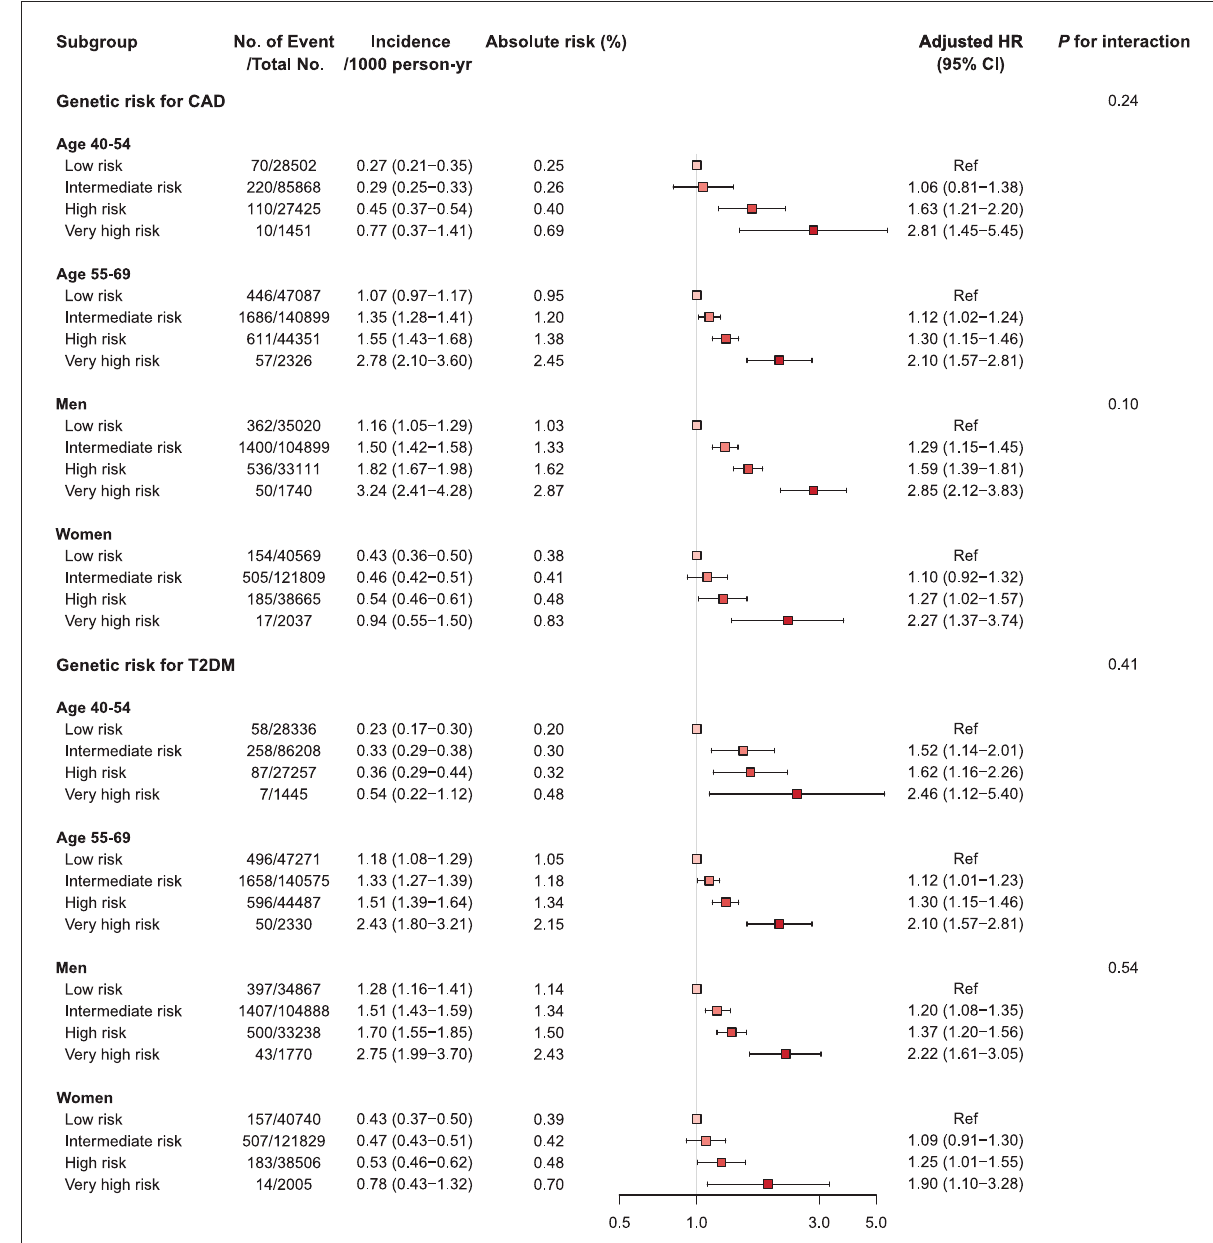
FIGURE3 Forest plot of cardiovascular mortality according to genetic risk, age, and sex. Cox regression model was adjusted for age, sex, genotyping array, and first ten principal components of ancestry. p -values are for testing the interaction between each genetic risk category, age, and sex. CAD, coronary artery disease; CI, confidence interval; HR, hazard ratio; T2DM, type 2 diabetes